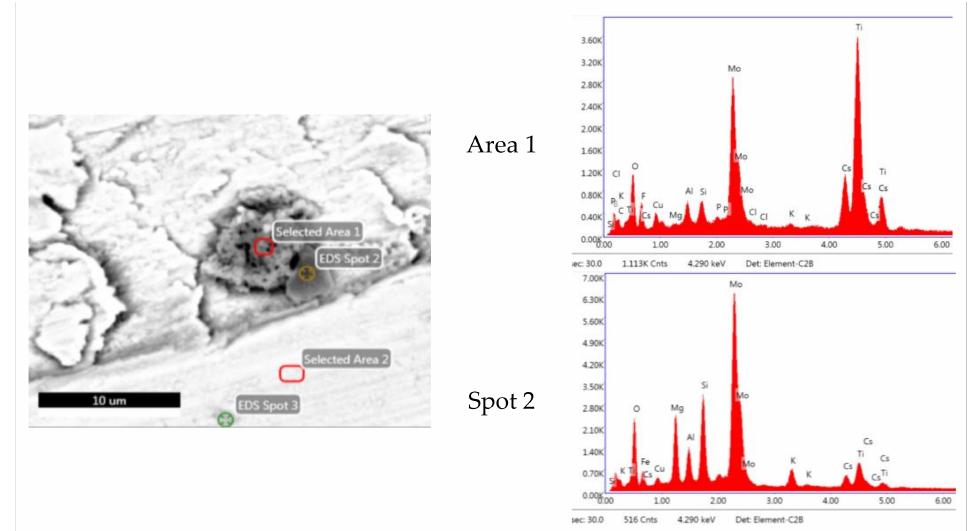
Figure 10. EDS-SEM of structures made of titanium.